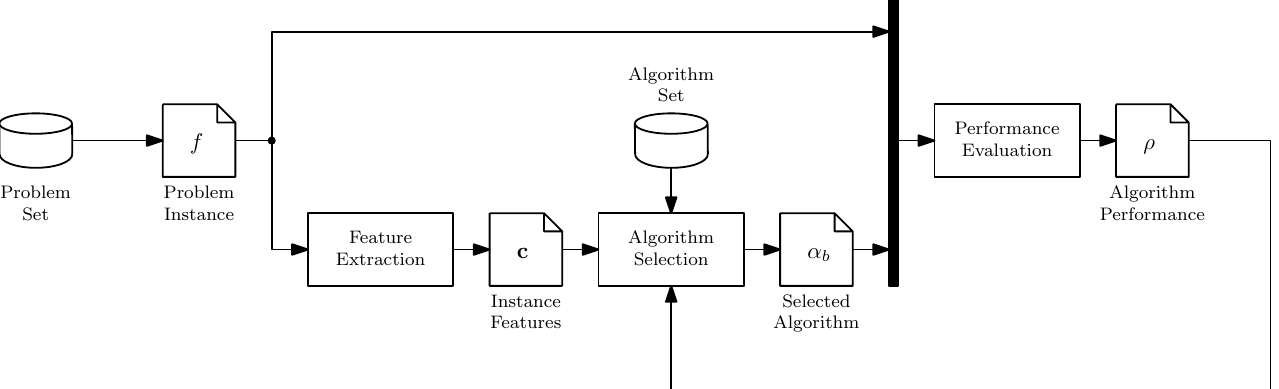
Figure 1. Diagram of the algorithm selector based on Rice’s framework [20]. The selector has three main components: Performance evaluation, Feature extraction, and Algorithm